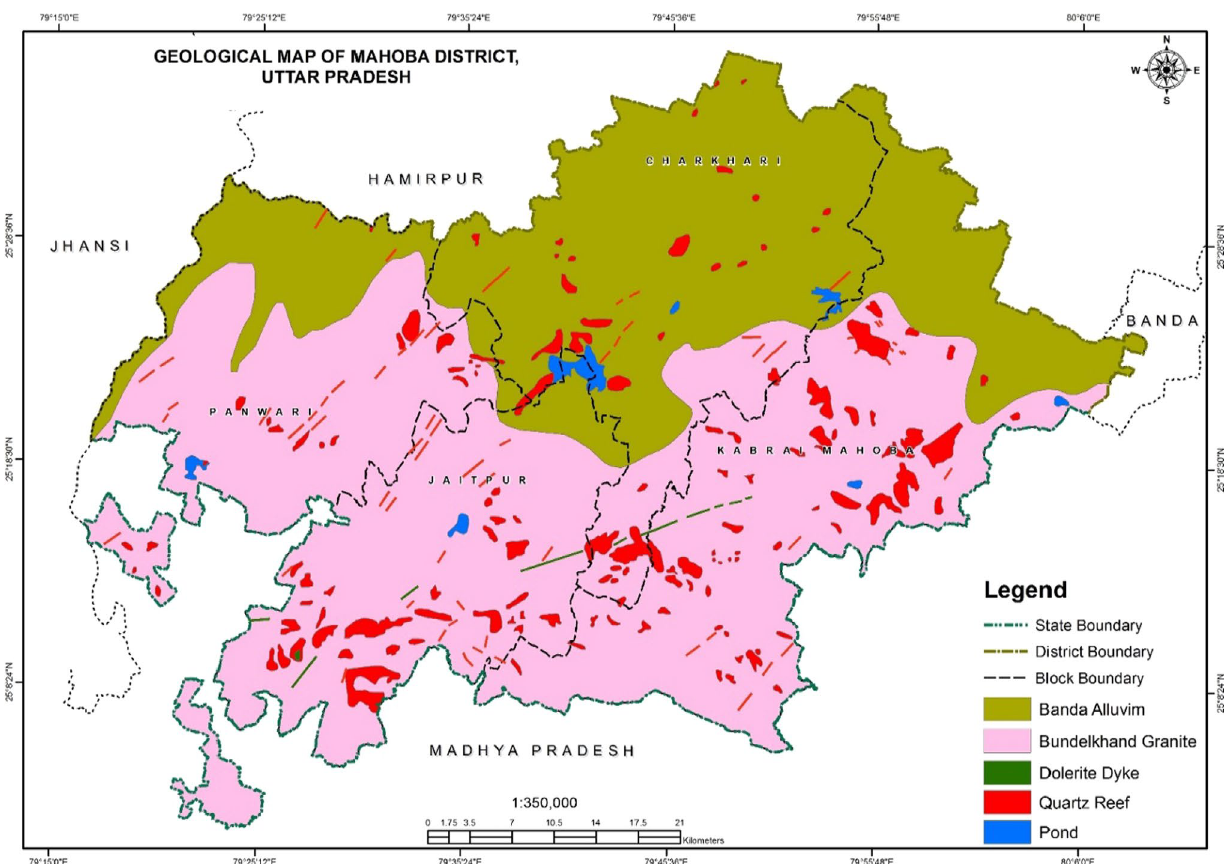
Fig. 2 Geological map of Mahoba